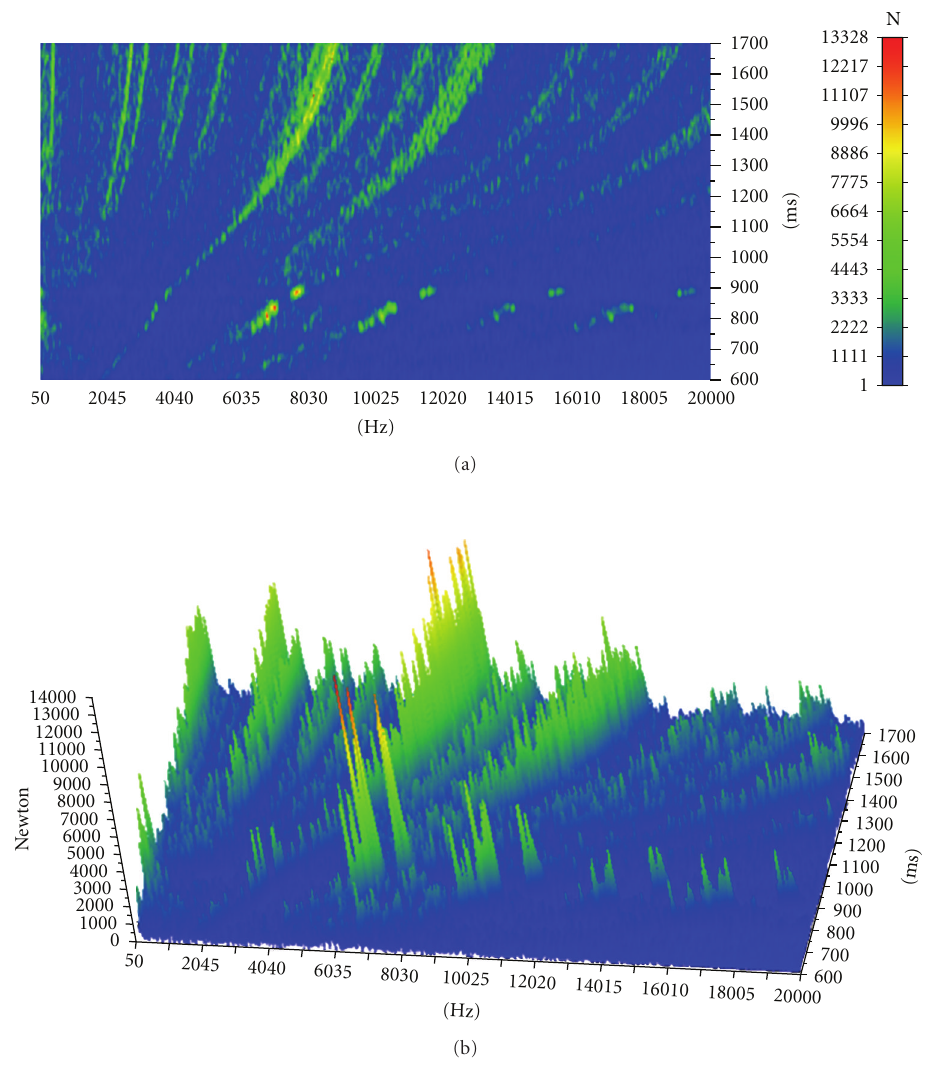
Figure 9: Three-dimensional FFT of force magnitude in Stage 1 for prescribed backlash and perfect geometry with the application of expo- nential step torque 149.6 N-m.